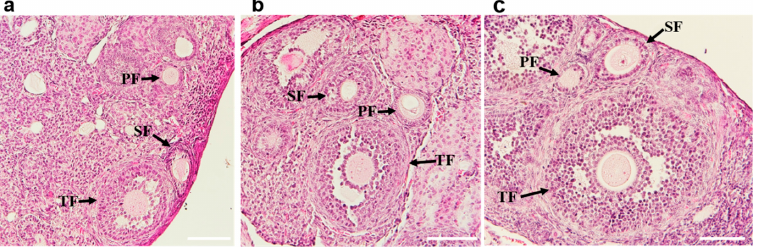
Figure 8. Histological analysis of the hematoxylin and eosin-stained ovarian sections of BALB/c mice. Ovaries of the mice immunized with GFP-mZP3-1 ( a ) and mZP3-3 ( b ) showing normal folli- cles at different stages of development as in ovaries from mouse immunized with PBS ( c ). PF, pri- mary follicles; SF, secondary follicles; TF, tertiary (antral) follicles. Scale bars = 100 μ m. 3.6. Reactivity of Serum Antibodies with the Mouse ZP Matrix by Indirect Immunofluorescence An indirect immunofluorescence assay was conducted to evaluate the binding of se- rum antibodies to the ZP matrix in BALB/c and wild mice. The results showed that the antibodies generated against the plant-produced GFP-mZP3-1 or mZP3-3 did not react with the ZP matrix surrounding the oocytes in BALB/c mice. Fluorescence signals from immune sera were similar to those of pre-immune serum samples (Figure 9a). However, immunofluorescence studies with wild mouse ovarian sections showed that serum anti- bodies from both immunized groups recognized the ZP matrix. Immune sera of immun- ized mice bound to the ZP of wild mouse ovarian sections, whereas pre-immune serum samples from the same animal did not show reactivity to the ZP matrix (Figure 9b).